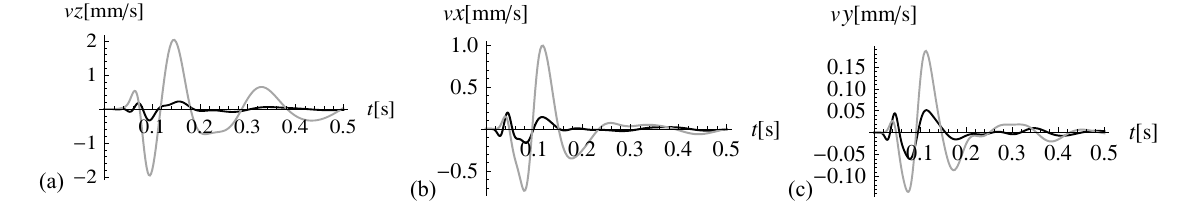
Fig. 7. AMF with the three displacement components, for the points located below the ground surface, for y = 35 m, r = 2 m; plot range: 0 < AMF < 1; (a) displacement component in the z -direction, (b) displacement component in the x -direction, (c) displacement component in the y -direction